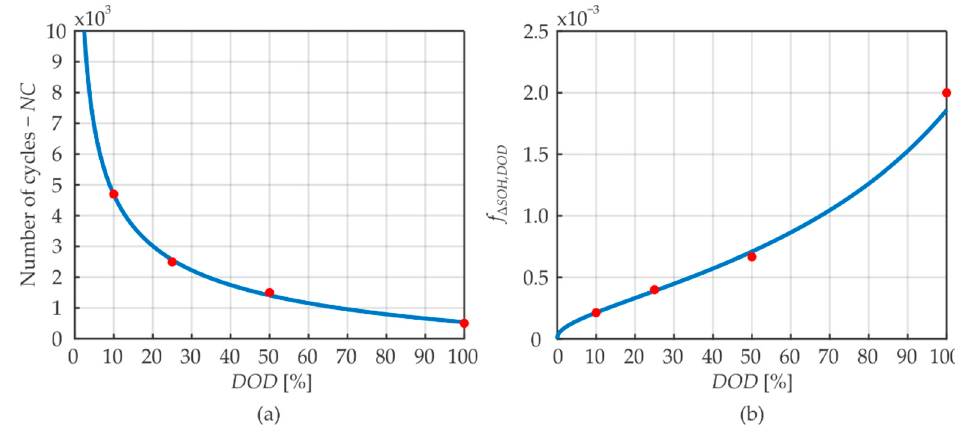
Figure 1. Influence of the depth of discharge DOD : ( a ) number of cycles and ( b ) f Δ SOH,DOD .